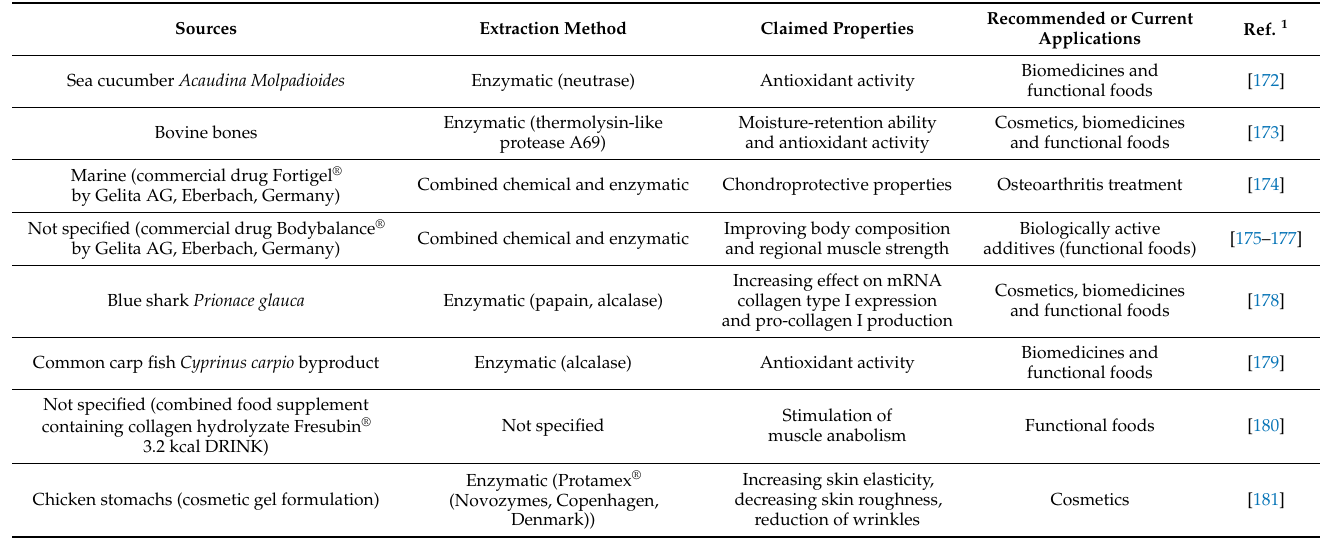
Table 3. Characteristics and applications of collagen